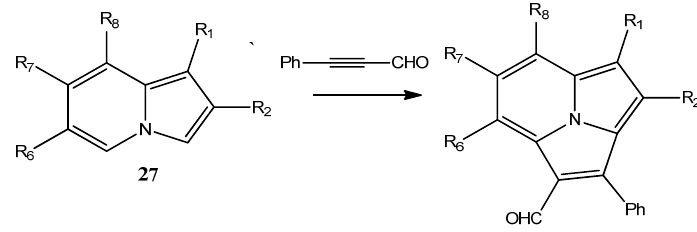
Table 4. Substituents and yields of photochemical cycloaddition to indolizines (Scheme